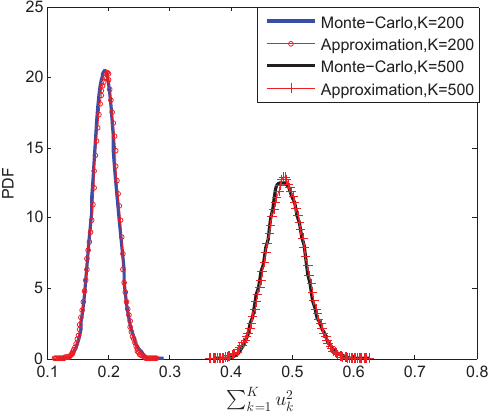
Figure A1. Monte Carlo simulation and approximation to the PDF of ∑ K